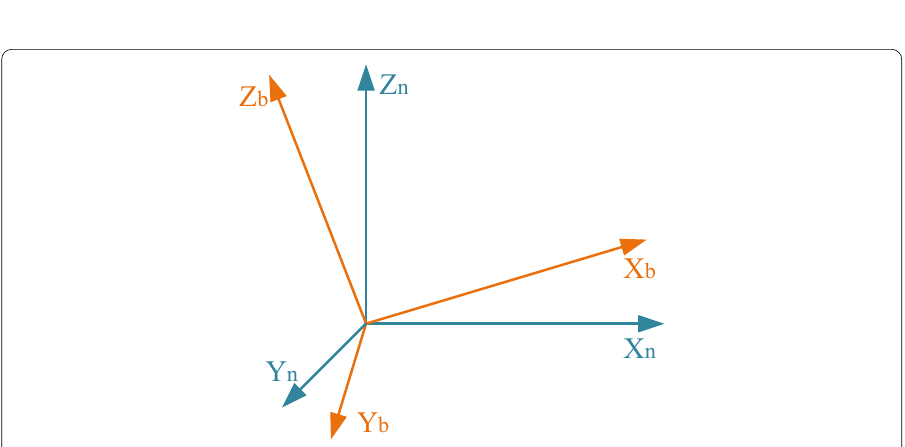
Fig. 4 Posture coordinate system O-XbYbZb, Geographic coordinate system